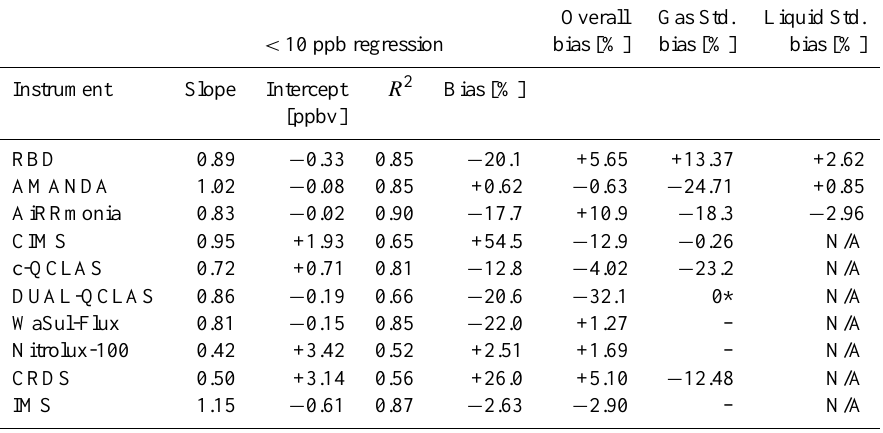
Table 2. Correlation of hourly NH 3 concentrations less than 10ppbv ( z =1.1m) between each instrument and the NH 3 − ens . Also shown are the bias for the entire data range and the data < 10ppbv, as well as the gas and liquid standard biases for all instruments. Overall Gas Std. Liquid Std. < 10 ppb regression bias [%] bias [%] bias [%] Instrument Slope Intercept R 2 Bias [%] [ppbv] RBD 0.89 − 0.33 0.85 − 20.1 +5.65 +13.37 +2.62 AMANDA 1.02 − 0.08 0.85 +0.62 +0.85 AiRRmonia 0.83 − 0.02 0.90 CIMS 0.95 c-QCLAS 0.72 DUAL-QCLAS 0.86 WaSul-Flux Nitrolux-100